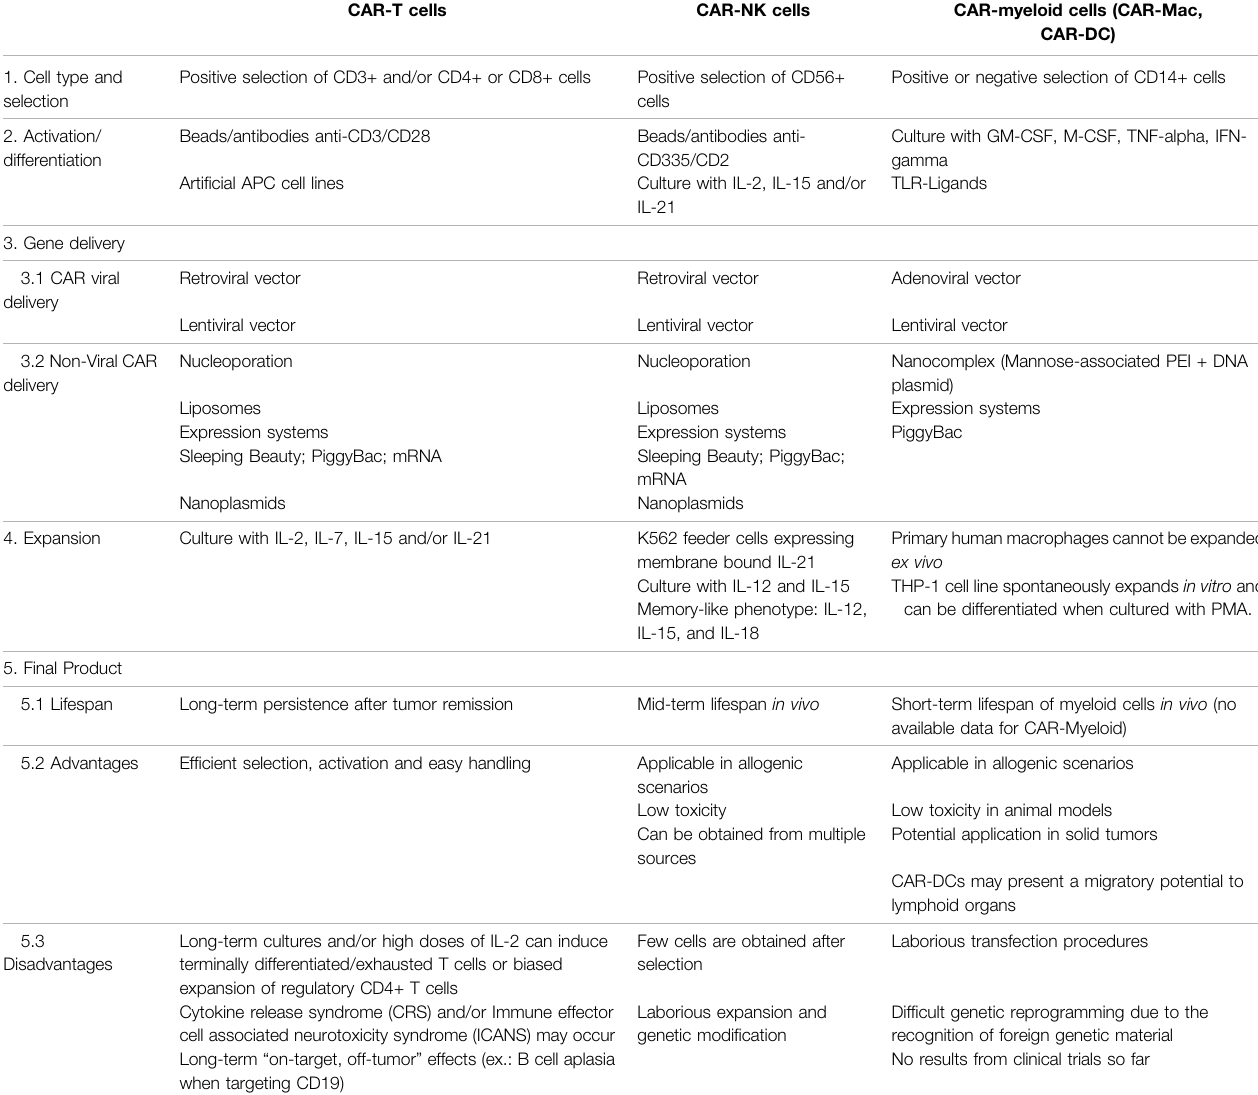
TABLE 1 | Comparison of key manufacturing steps for CAR-based cellular products (CAR-T, CAR-NK, and CAR-Myeloid cells) and its speci fi c advantages and disadvantages. PEI, Polyethylenimine; GM-CSF, Granulocyte-macrophage colony-stimulating factor; M-CSF, Macrophage colony-stimulating factor. CAR-T